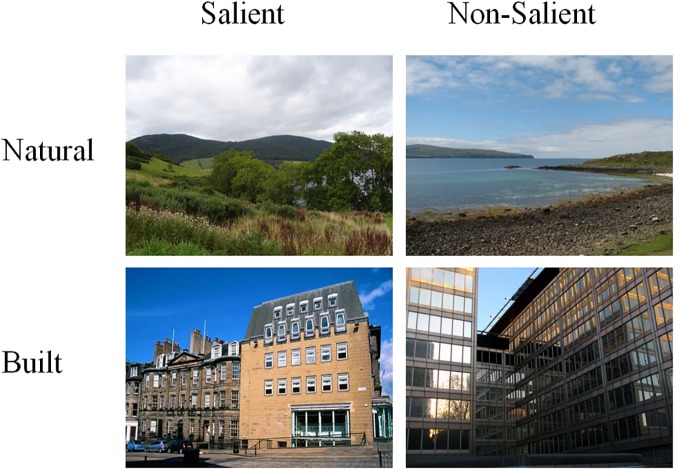
Examples of salient and non-salient natural and built images as used in Experiment 3.